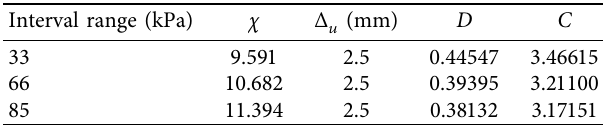
Table 3: Model parameter values obtained by interpolation under normal stress of 42kPa.